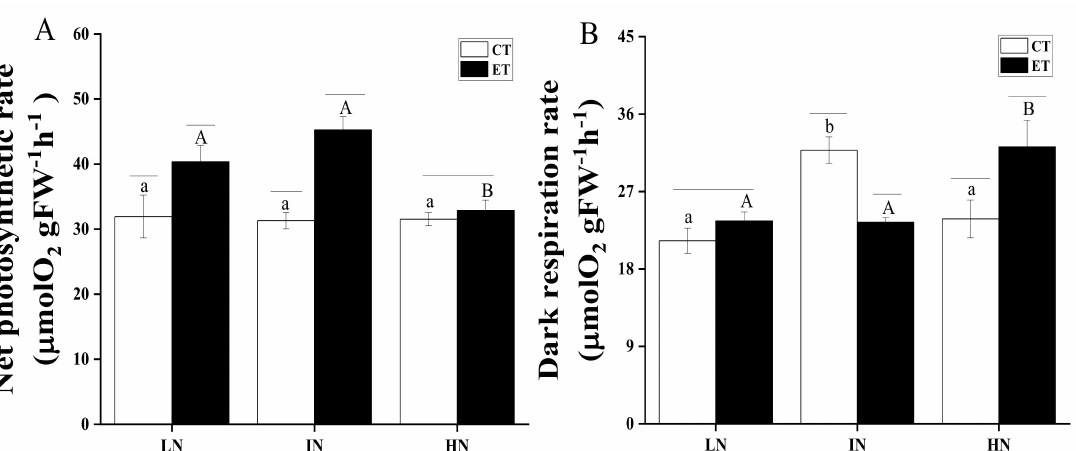
Figure 4. Net photosynthetic rate( A ) and dark respiration rate ( B ) of S. horneri under LN, IN, and HN, treated by CT and ET. Data are means ± SD (n = 3) Horizontal lines represent significant differences ( p < 0.05) among the temperature levels at the same N concentration, the different capital letters represent significant differences ( p < 0.05) among N concentrations at the elevated temperature, while the different lower-case letters represent significant differences ( p < 0.05) among N concentrations at the ambient